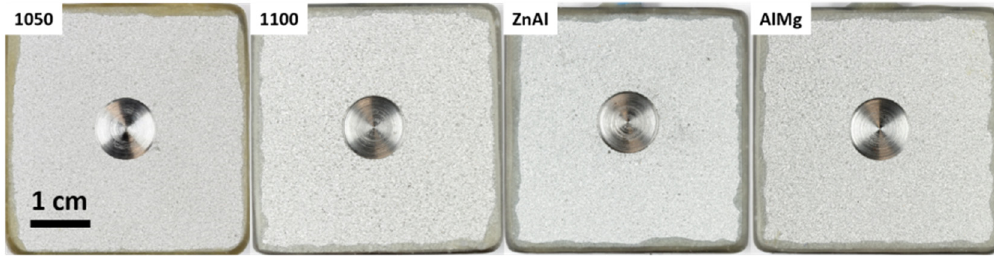
Figure 1. Thermally sprayed coated samples with 5% of surface area defect before exposure.